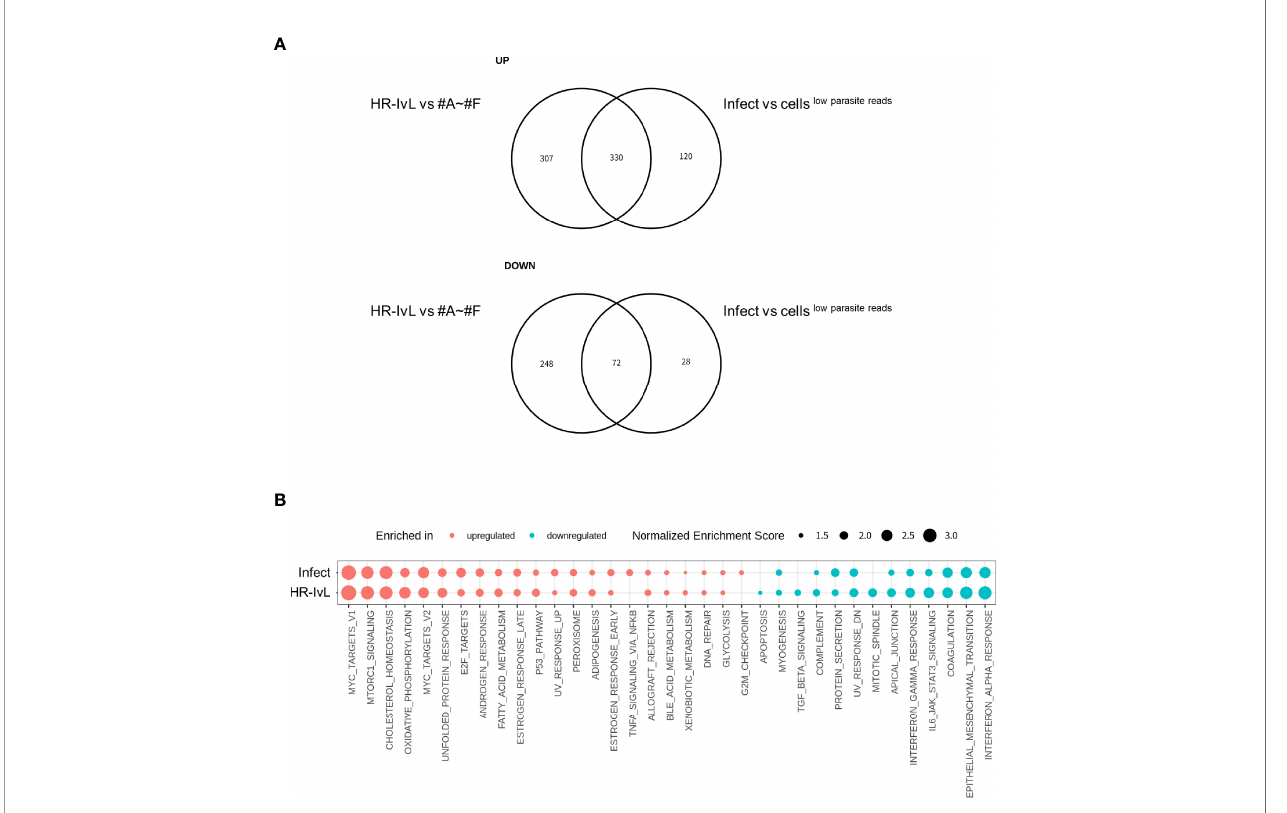
FIGURE 3 | Altered host gene expression in infected cells is correlated with that detected in the host cell subset “ HR-IvL ” . (A) Genes with log 2 fold change over 0.5 and Benjamini – Hochberg adjusted p-value (False Discovery Rate: FDR) less than 0.05 were fl agged as differentially expressed genes (DEGs). Upregulated (top panel) or downregulated (bottom panel) DEGs in infected cells vs. cells low parasite reads were compared with those in “ HR-IvL ” vs. “ #A – #F ” clusters. (B) Normalized enrichment scores for gene set enrichment analysis (GSEA) are shown. Enriched pathways for upregulated genes are shown in red, and those for downregulated genes are shown in blue. Enriched pathways with FDR less than 0.05 in either infected cells vs. cells low parasite reads or HR-IvL vs #A – #F are shown. Pathways with FDR < 0.05 are shown with solid circles. “ Infect ” and “ HR-IvL ” indicate infected cells vs. cells low parasite reads and HR-IvL vs. #A – #F.